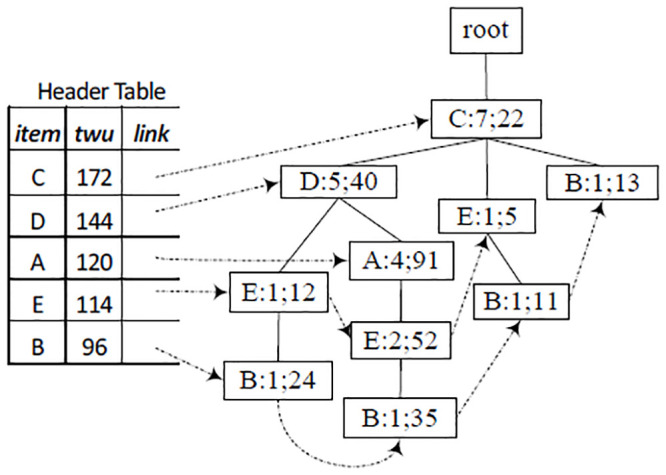
UP-Tree [10] based on toy data in Tables 1 and 2 (η = 70).